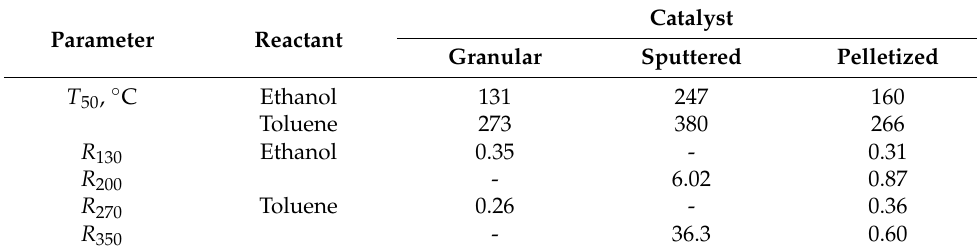
Table 8. T 50 temperatures and specific reaction rates R T , mmol g oxides − 1 h − 1 , for the sputtered, granular and pelletized NiCu11 catalysts in ethanol and toluene